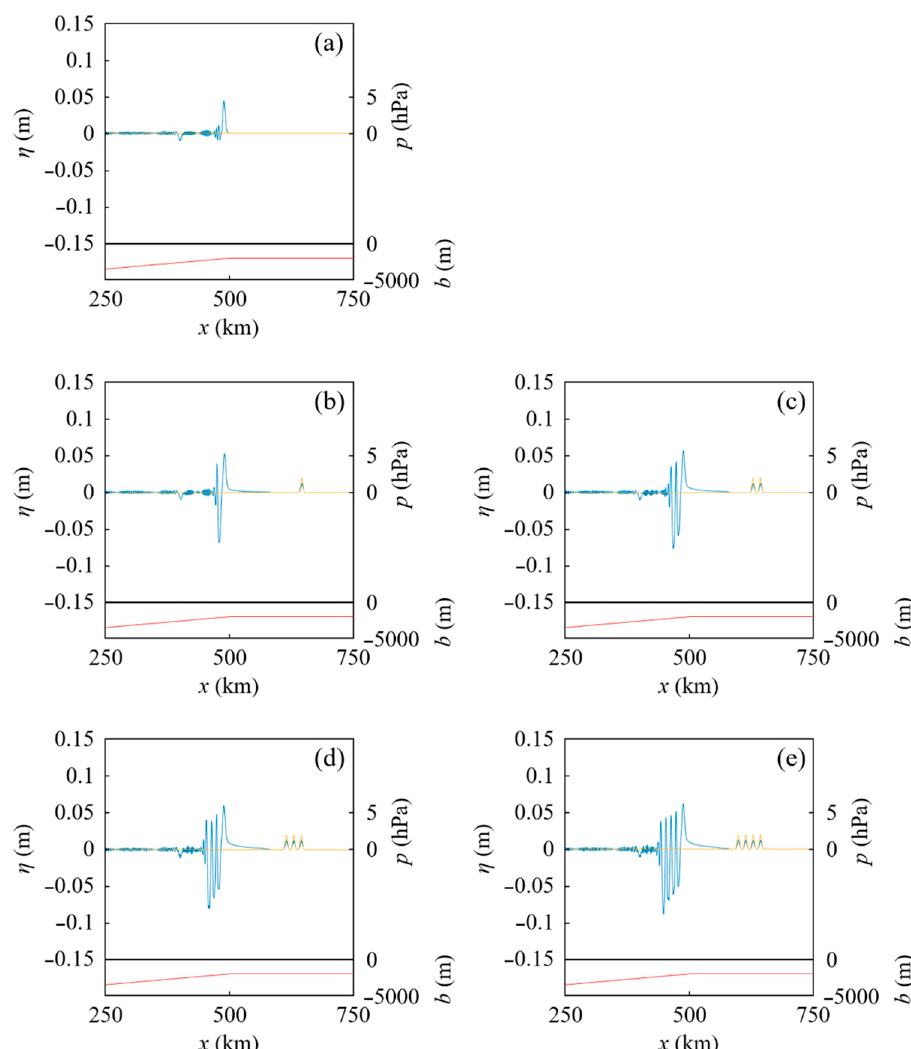
Figure 4. Water surface profiles at t = 2380 s in Case B, in which x 1 = 55 km and δ = 5 km in Figure 1; h on = 2000 m, x slope = 20 km, x on = 500 km, and the slope gradient β = 6.25 × 10 − 3 in Figure 2b. The blue, orange, and red lines indicate the water surface displacement η , atmospheric pressure p , and seabed position b , respectively. ( a ) The existing tsunami T Lamb propagated with no atmospheric pressure wave. ( b ) T Lamb was amplified by W 1 . ( c ) T Lamb was amplified by W 1 and W 2 . ( d ) T Lamb was amplified by W 1 , W 2 , and W 3 . ( e ) T Lamb was amplified by W 1 , W 2 , W 3 , and W 4 .